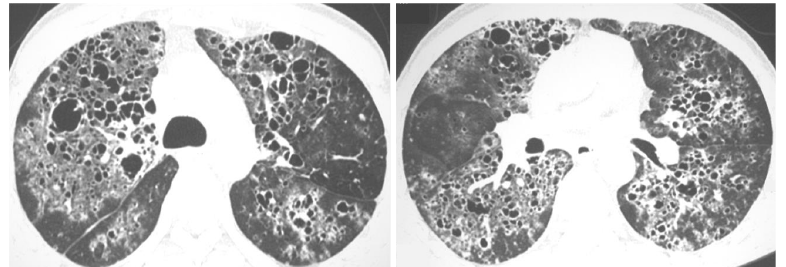
Figure 11 . Pneumocystis pneumonia in a patient with acquired immunodeficiency syndrome (AIDS). Axial CT images from upper and lower levels (from left to right ) reveal diffuse bilateral ground-glass opacities with some peripheral sparing. Multiple bilateral pneumatoceles of varying size, shape and wall thickness are also visualized.